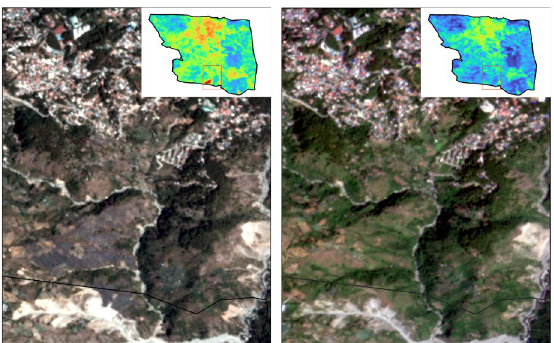
Figure 5. PlanetScope images on March 25, 2019 (left) and March 09, 2022 (right). The left image shows the presence of burned vegetation in the southern part of the city that resulted in high LST values.